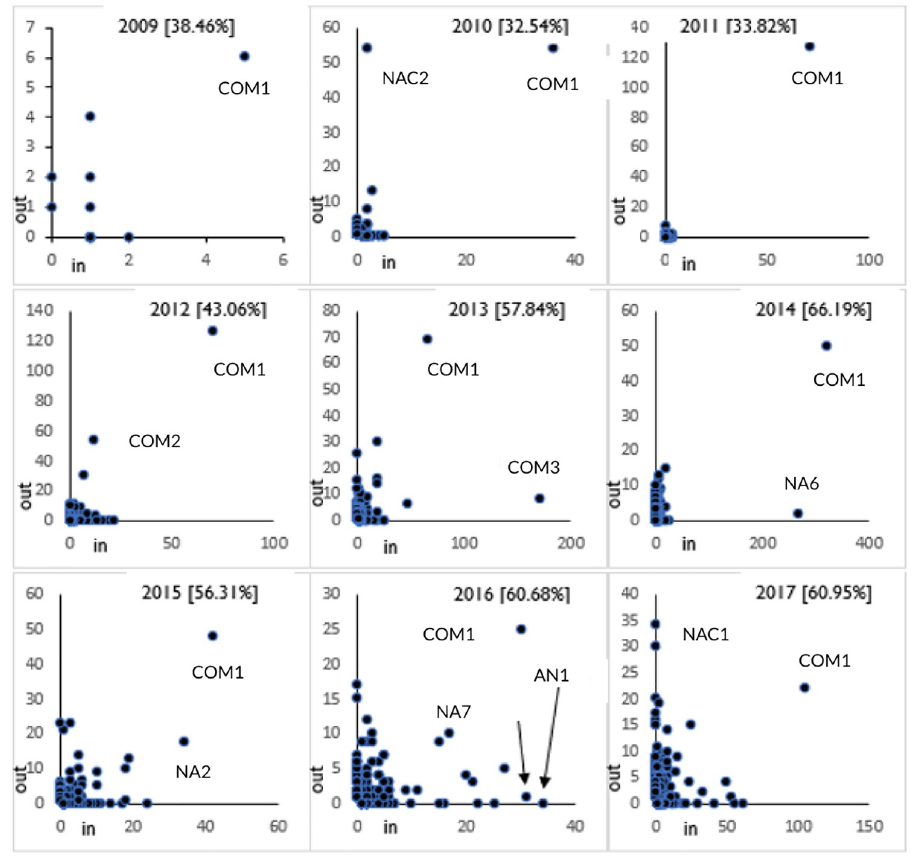
Fig 5. Plots of in-degree values (posting) against out-degree values (tagging) demonstrating online behaviour for key influencers are plotted in scatter plots for the years 2009–2017. The top two accounts with highest degree values are labelled in these plots. In addition, the percentage of accounts which have out-degree values more than in-degree values are displayed alongside the year in the plots. COM (Commerical Organizations) consistently appear as top accounts across the years. The tagging behavior is dominant until 2012 while posting behavior takes precedence in the last five years of the analysis